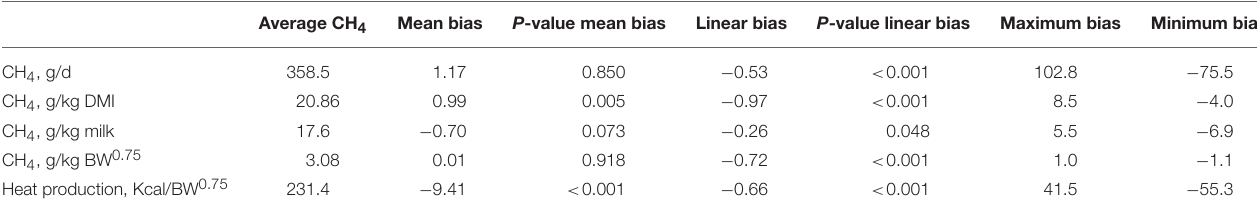
TABLE 7 | Evaluation of bias for CH 4 outputs (g/d, g/kg DMI, g/kg milk, and g/kg BW 0.75 ) and heat production (Kcal/BW 0.75 ) measured using face-mask and respiration chambers in dairy cows fed replacing concentrations of soybean meal (SBM) with soybean cake (SBC). Average CH 4 Mean bias P -value mean bias Linear bias P -value linear bias Maximum bias Minimum